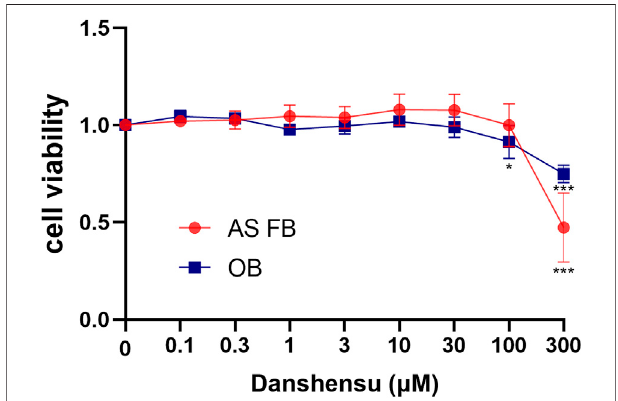
FIGURE 5 | Viability of osteoblasts and AS fi broblasts treated with Danshensu at different concentrations.